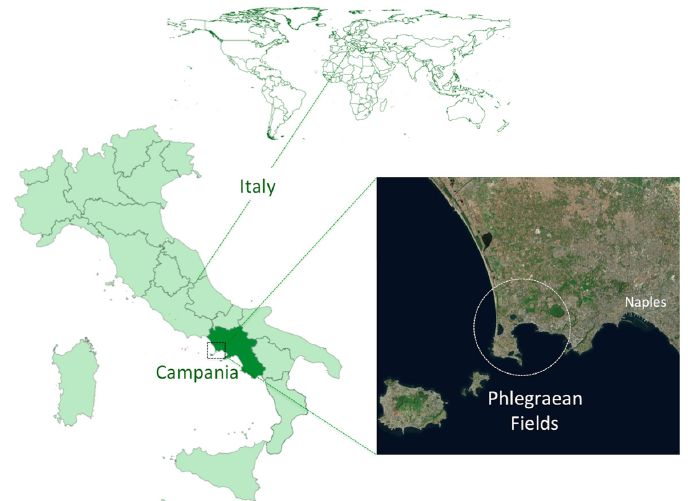
Figure 6. Investigated area: Phlegraean Fields (Campania Region—Southern Italy).